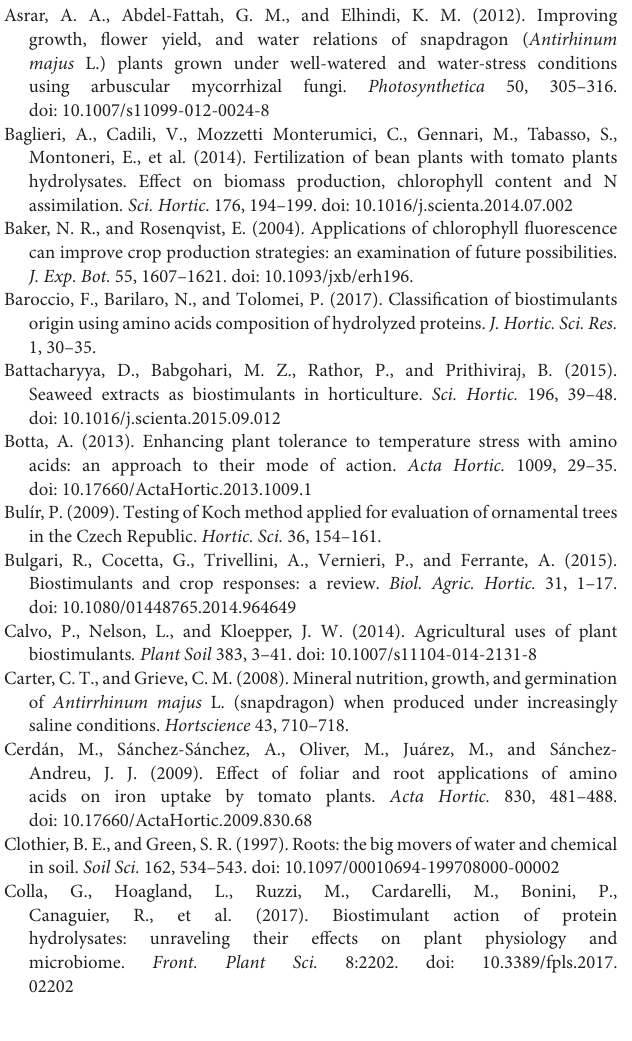
Table S1 | The effects of the interaction between biostimulant dose and application methods on snapdragon plants characteristics: shoots (n /plant), flower (n /plant), flower dry weight (g/ plant), ground dry weight (g/plant), projected root area (cm 2 /plant), total leaf-N (mg kg − 1 ), concentration of CO 2 (ppm). Table S2 | The effects of the interaction between biostimulant dose application methods and cultivar on snapdragon plants characteristics: total shoot length (cm /plant), total leaf area (cm 2 /plant), flower dry weight (g/ plant), total above dry